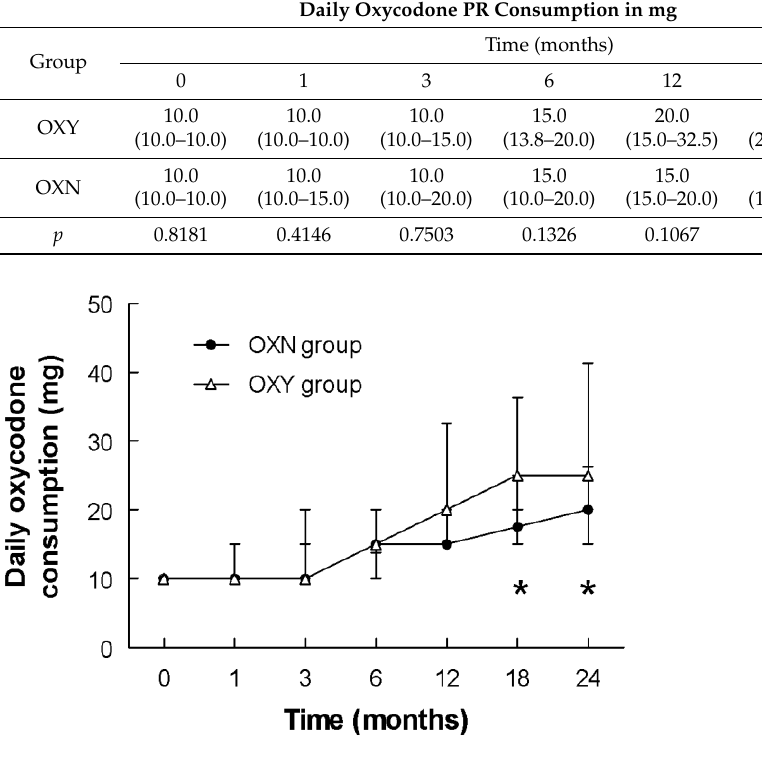
Figure 1. Time course of daily oxycodone consumption (mg) to reach the target 30% pain relief versus baseline. Data are expressed as median and interquartile range (IQR, 25–75). OXY group: oxycodone; OXN group: oxycodone-naloxone. * p < 0.05 between the two groups at the different time points.